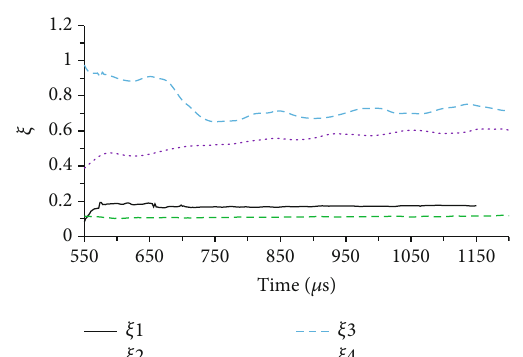
Figure 18: Stress distribution dispersion over the thickness of the